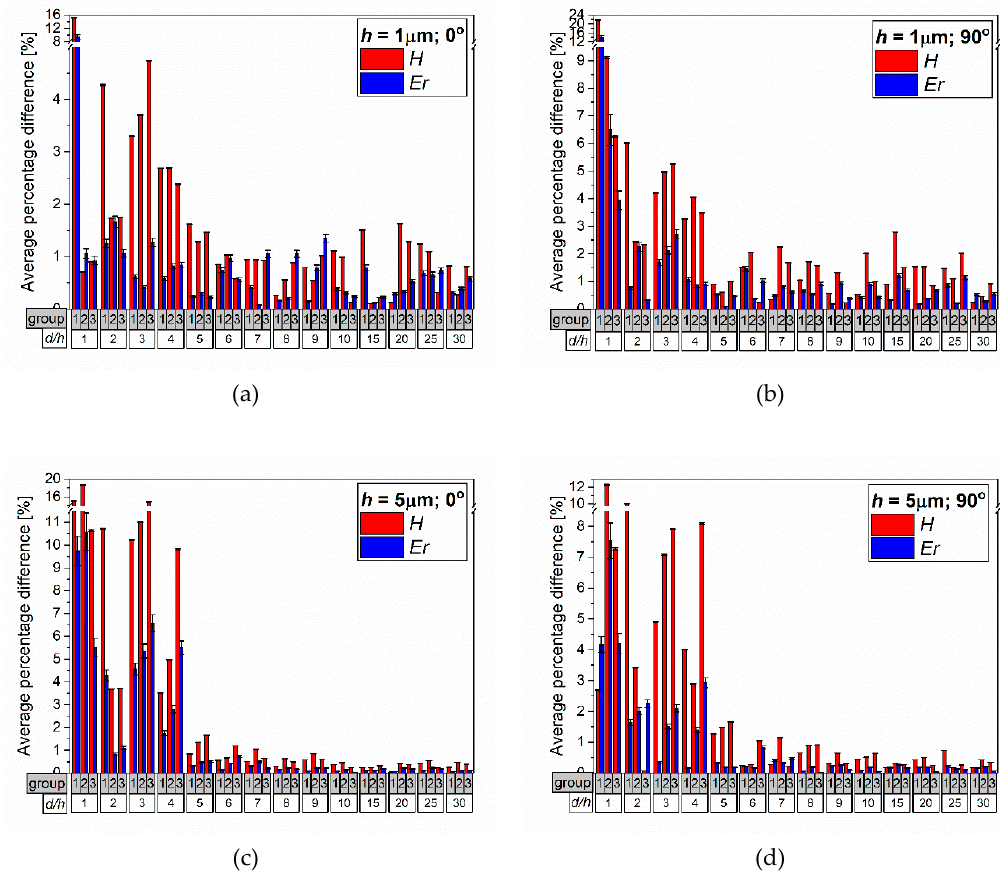
Figure 8. Average percentage difference of hardness and modulus values for three indents within a group for various maximum indentation depth and separation. ( a ) orientation 0°, h = 1 µm; ( b ) orientation 90°, h = 1 µm; ( c ) orientation 0°, h = 5 µm; ( d ) orientation 90°, h = 5 µm.